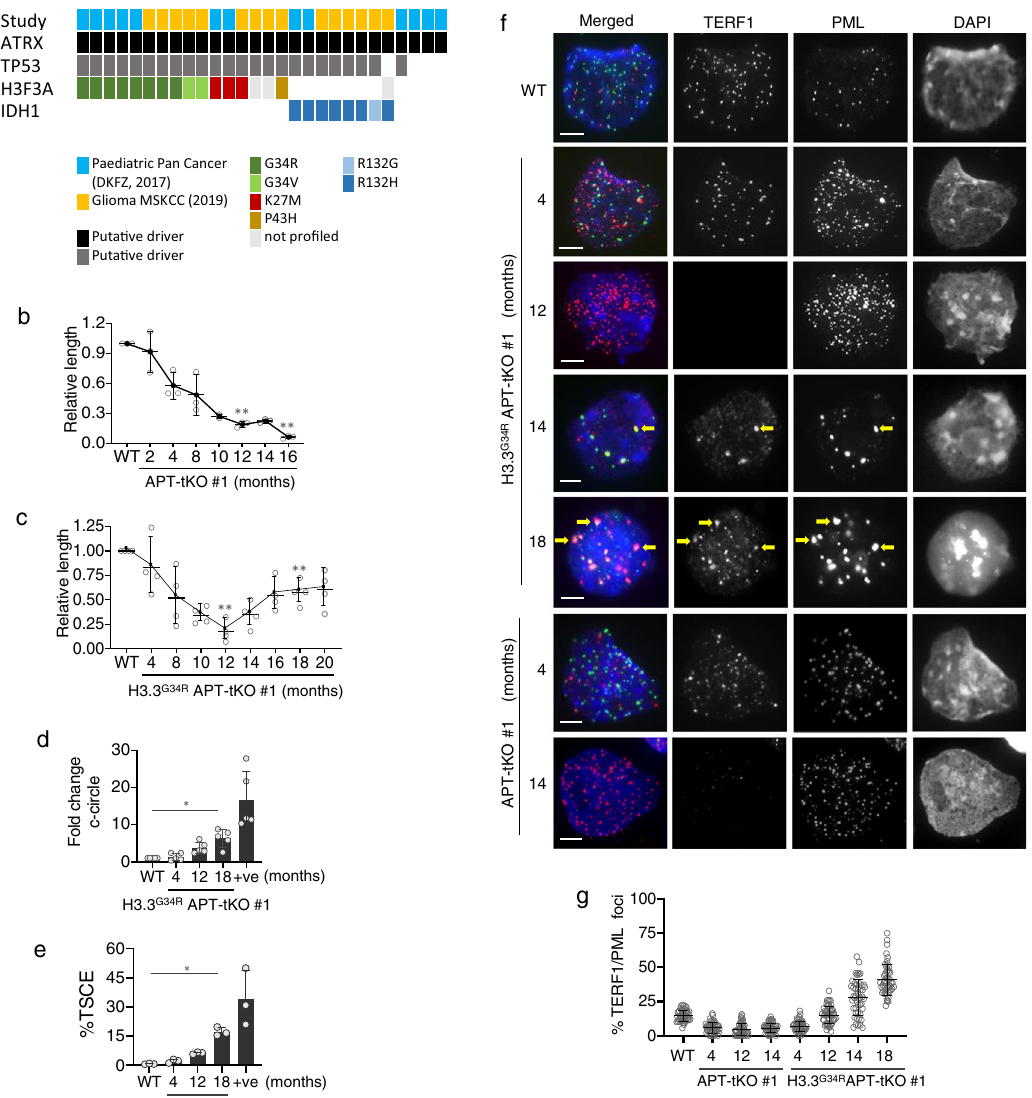
Fig. 1 H3.3 G34R promotes ALT in APT-tKO mouse ES cells. a Glioblastoma tumours from patients aged 30 years and younger with ATRX, H3.3, IDH1 and TP53 mutations. b, c Telomere length analyses of APT-tKO #1 and H3.3 G34R APT-tKO #1 ES cells, in relative to WT (wildtype) ES cells ( n = 3 independent experiments). d Detection of telomeric C-circle in H3.3 G34R APT-tKO cells ( n = 5 independent experiments). e Detection of T-SCE in H3.3 G34R APT-tKO cells ( n = 3 independent experiments). Human U2OS osteosarcoma ALT cell line was included as a positive ( + ve) control. f, g Immunostaining of APBs in APT-tKO cells and H3.3 G34R APT-tKO, shown by co-staining of TERF1 (green; diluted at 1/500) and PML (red; diluted at 1/800) (arrows). Scale bars: 5 μ m; representative images from at least n = 3 independent experiments. Percentages of co-localised TERF1 and PML foci in H3.3 G34R APT-tKO#1 cells are shown in g . For each cell line, >1500 telomeric foci were counted ( n = 3 independent experiments; indicated by TERF1 staining). Percentage of co-localised TERF1/PML foci are determined as percentages of telomeric foci that co-stained with PML over the total number of telomeric foci counted. b , c , d , e , g Data are presented as mean values ± SD. *indicates p < 0.05 and **indicates p < 0.005, Student ’ s t -test with two-tailed distribution. Source data are provided with this